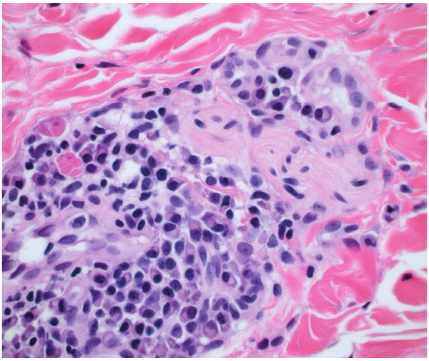
Figure 3: Abdominal biopsy was notable for perineural plasmacytes (hematoxylin & eosin stain; original magnification: ×